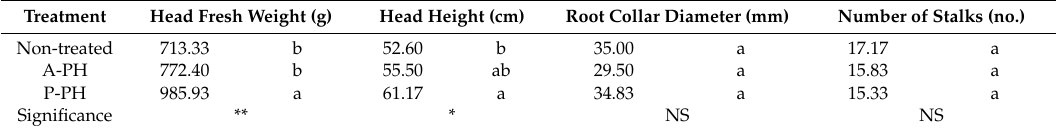
Table 1. E ff ect of di ff erent protein hydrolysates (PHs) on head fresh weight, head height, root collar diameter, and number of stalks of celery.